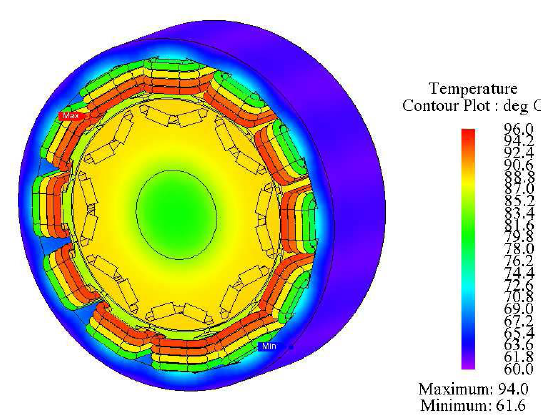
Figure 12. Implemented 3D-FEM thermal model with p m = 0.1 W/cm 3 at rated current and 9000 rpm (winding impregnation not shown).